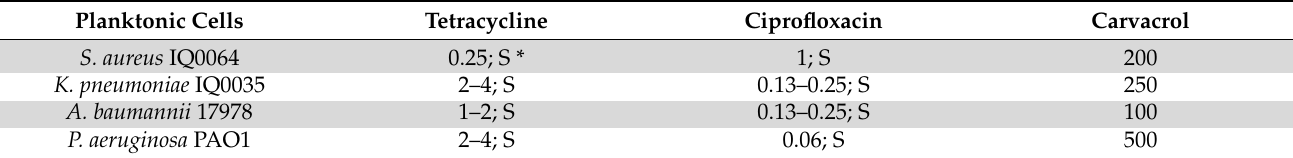
Table 2. MICs of the four common